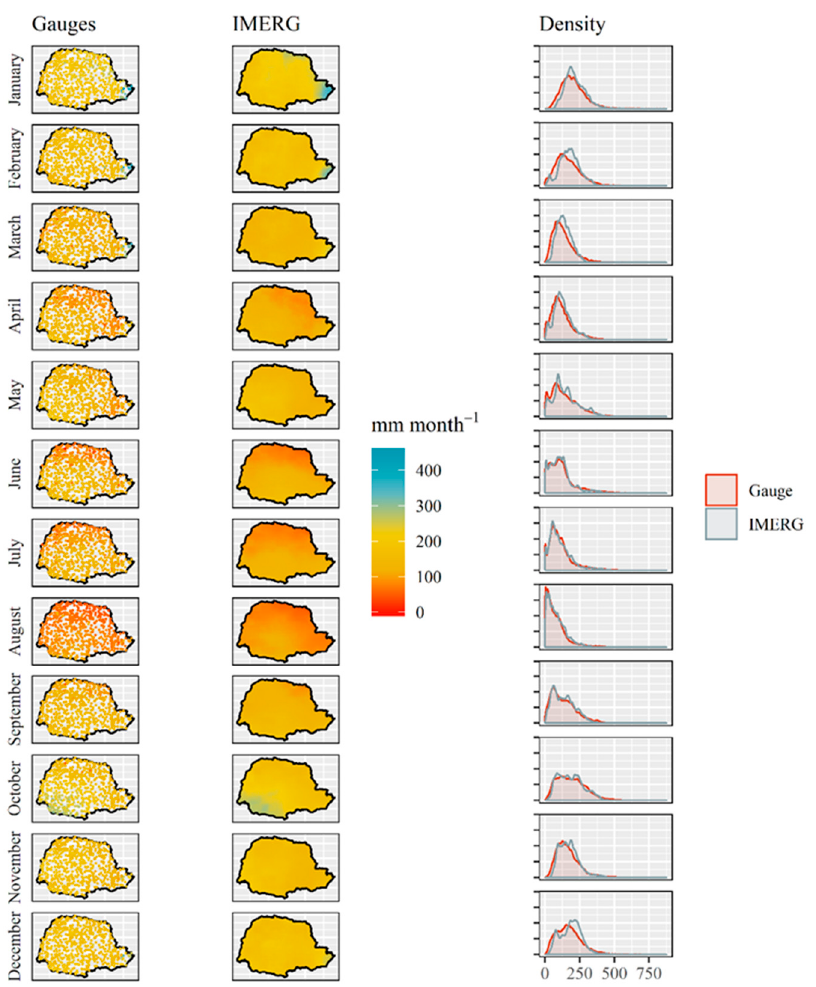
Figure 4. Average monthly rainfall observed during the study period for gauges and by IMERG, and density curve of monthly observations.